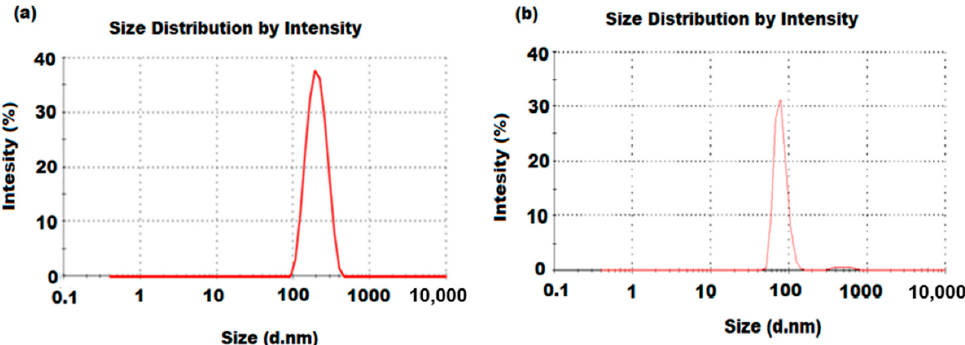
Figure 3. Particle size distribution of ( a ) NiONPs and ( b ) MnO 2 NPs synthesized by Mentha spicata and Malus domestica peel extract,